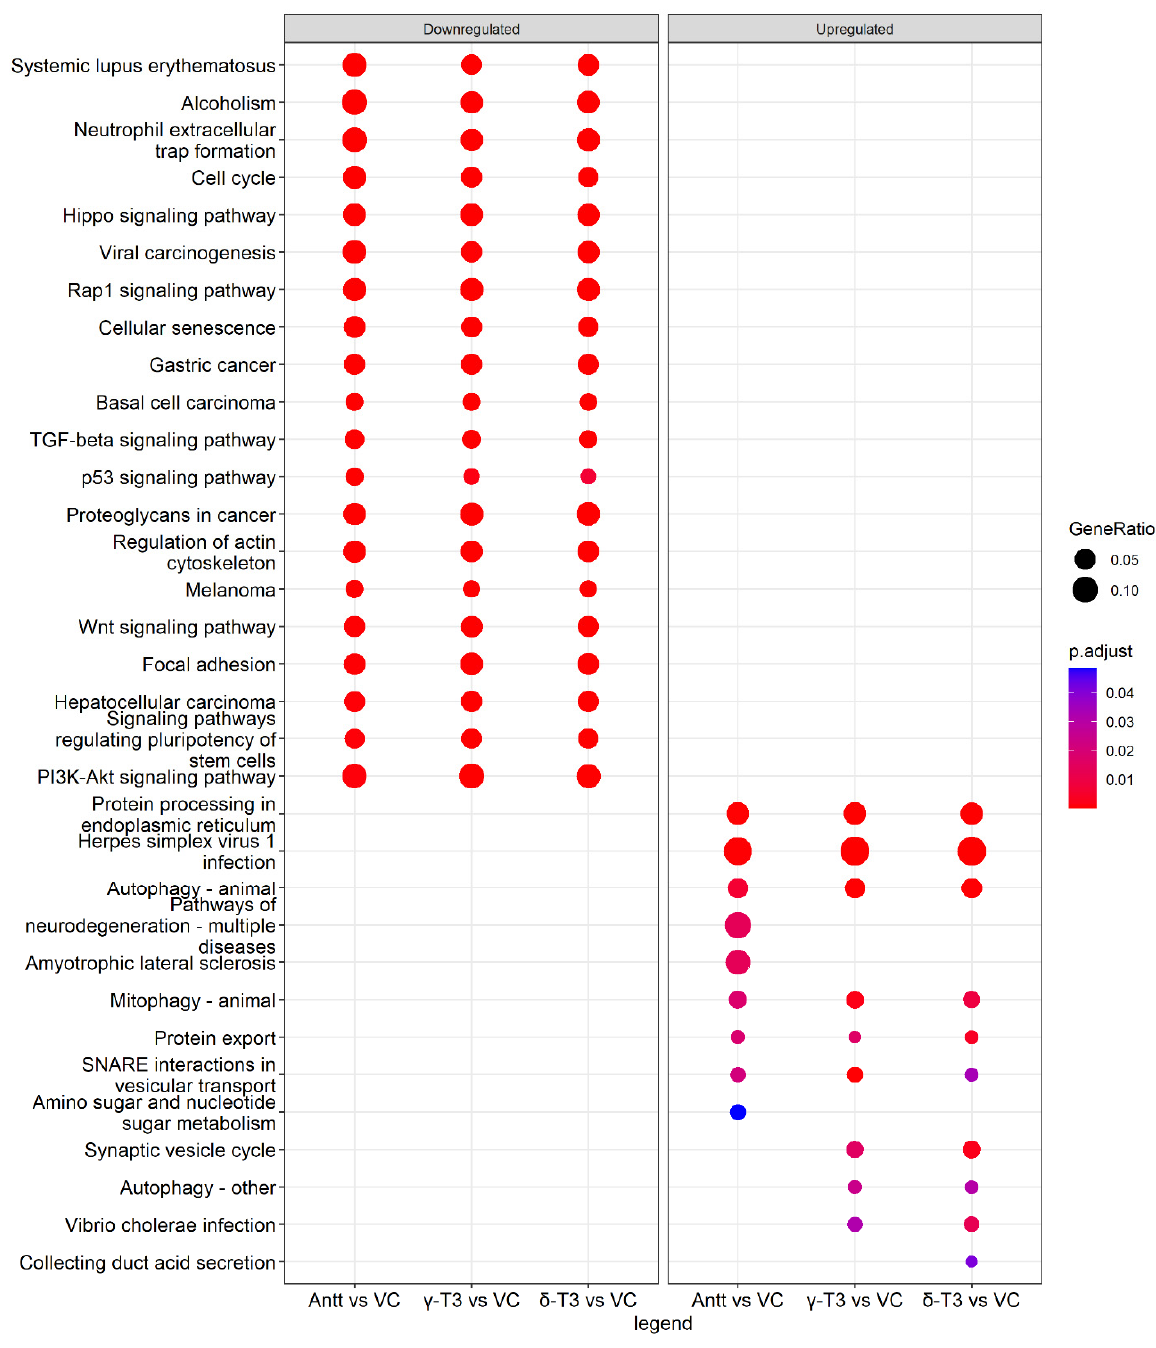
Figure 10. The KEGG enriched pathways with the upregulated DEGs for AnTT, γ -T3 and δ -T3 treatment as compared to VC. Abbreviations: Antt, annatto tocotrienol; δ -T3, δ -tocotrienol; γ -T3, γ -tocotrienol; DEGs, differentially expressed genes; VC, vehicle control.